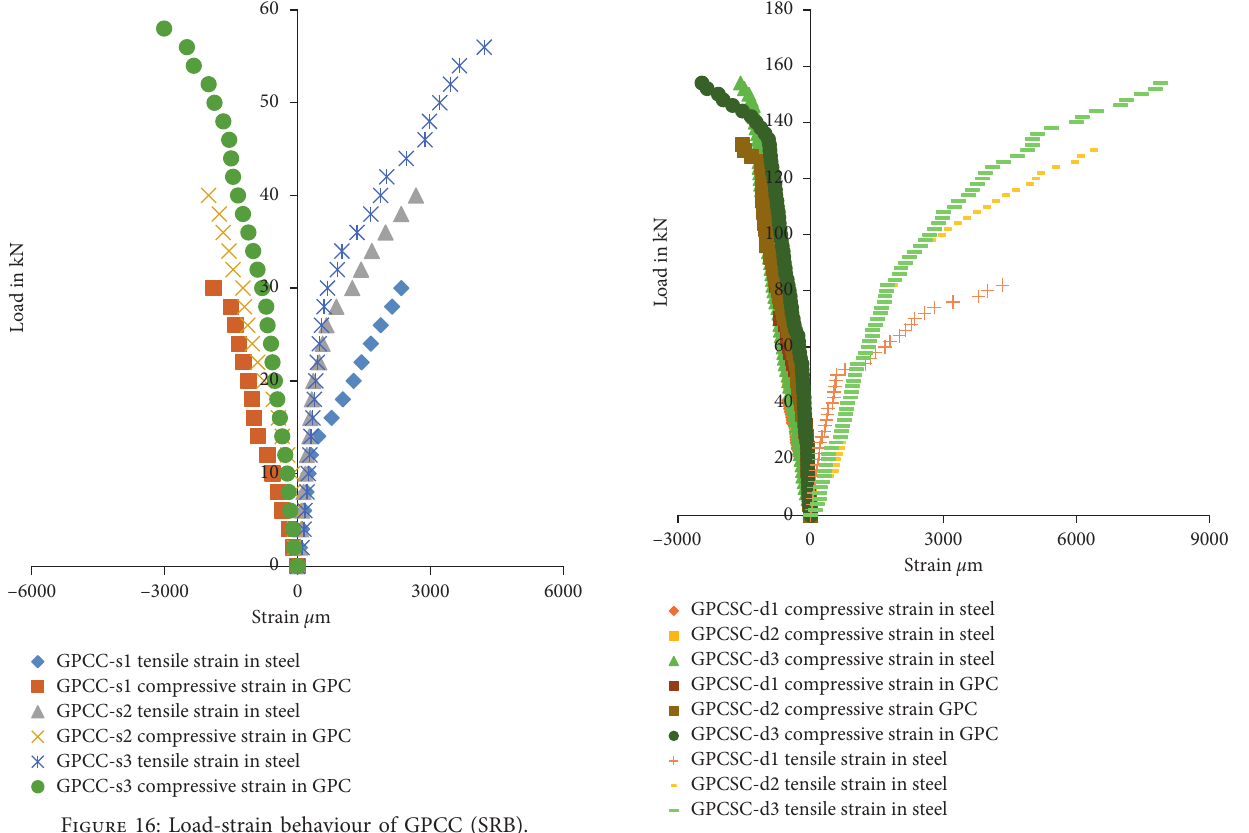
Figure 17: Load-strain behaviour of GPCSC